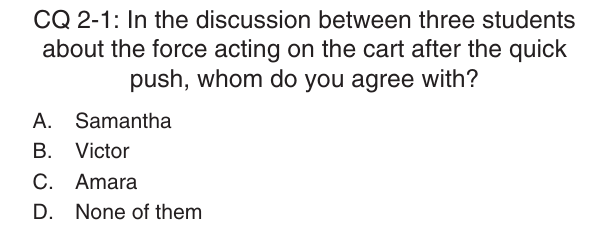
FIG. 9. The first clicker question in U2L02, corresponding to the discussion represented in Fig.